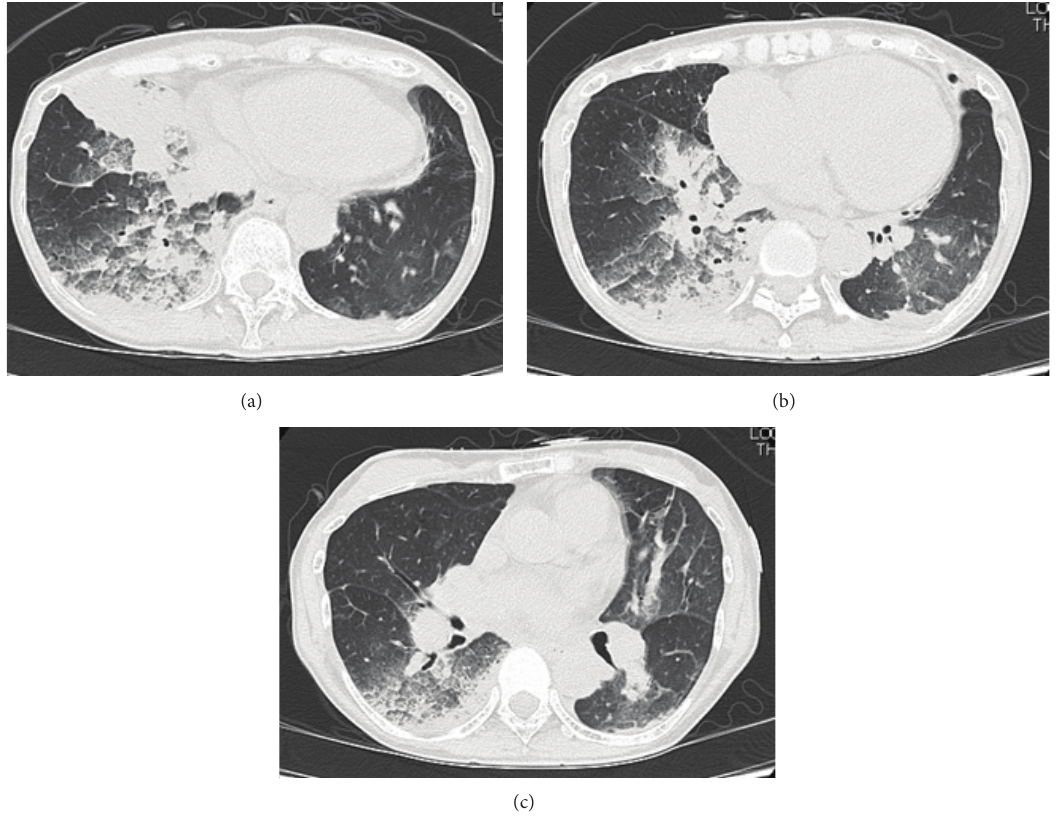
Figure 3: CT scan images obtained on the third postoperative day (POD3). The patient had localized consolidation on her right lower lobe with atelectasis, designating postsurgical pulmonary edema in the dilated